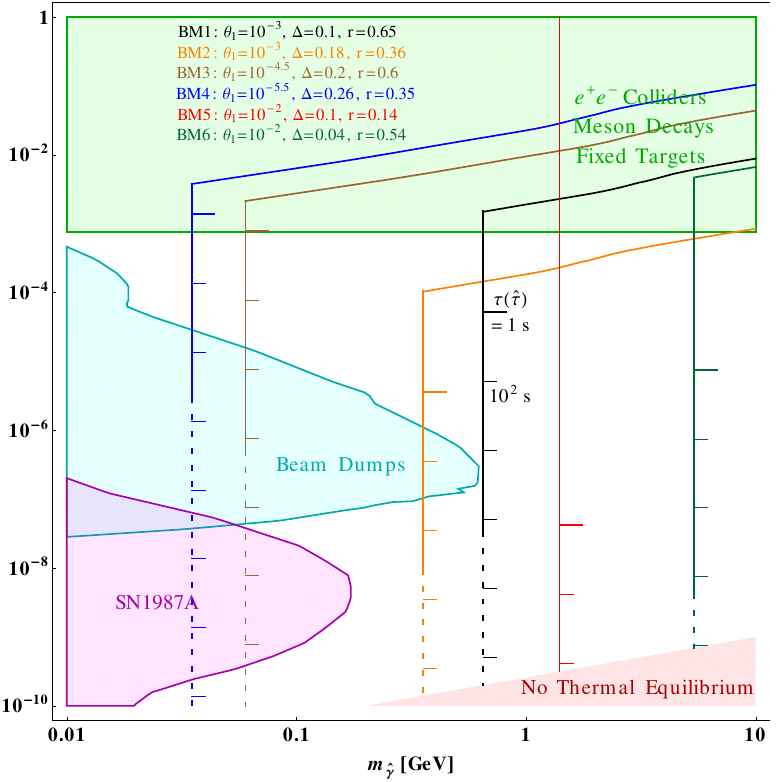
Figure 8 . Constraints on the kinetic mixing parameter (cid:15) and the twin photon mass m ^ (cid:13) . The green and cyan shaded regions are ruled out by lab experiments. The magenta shaded region is the constraint from SN1897A cooling. In the red shaded region (cid:15) is too small to keep ^ (cid:13) in thermal equilibrium with the SM. We also plot 6 benchmark models which give the correct DM relic density from the numerical calculations in section 5. For small enough (cid:15) , models 1, 3, 4, and 6 are in the coscattering phase and model 2 is in the mixed phase. At large values of (cid:15) these model curves turn right because the three-body (inverse) decay rate becomes large and freezes out after the coannihilation process, driving the models into the coannihilation phase. Model 5 is in the coannihilation phase for all (cid:15) large enough to keep ^ (cid:13) in thermal equilibrium. The ticks on each benchmark curve represent ^ (cid:28) lifetime, starting from (cid:28) (^ (cid:28) )=1 sec and increasing by 10 2 each tick below. The dashed parts of the curves are ruled out by the BBN